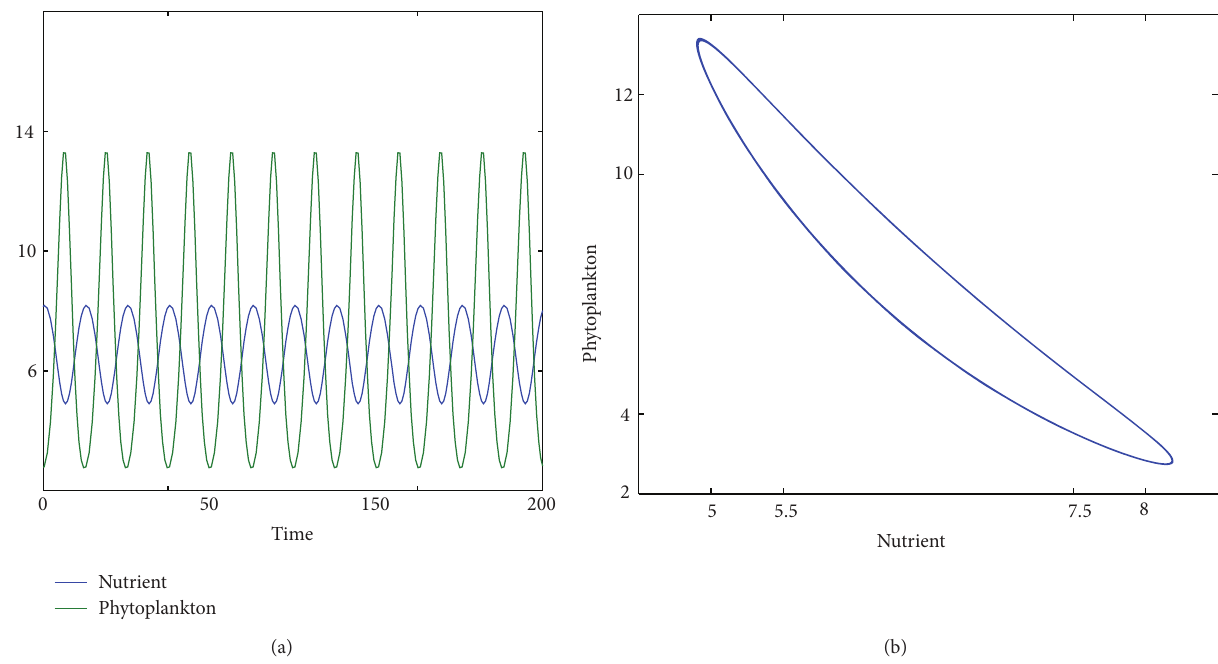
Figure 3: (a) The solutions for nutrients and phytoplankton for 𝑁 0 = 10, ℎ = 1 , and 𝜏 = 3.6 ; (b) phase diagram.